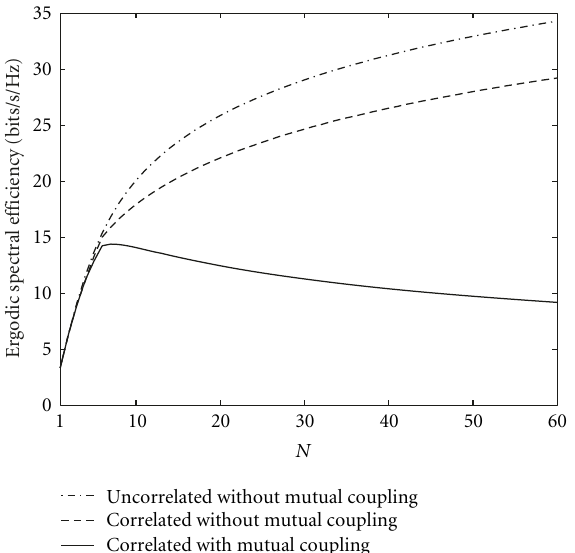
Figure 6: Ergodic spectral e ffi ciency of a compact MIMO system with AS, where M = 5 and N =